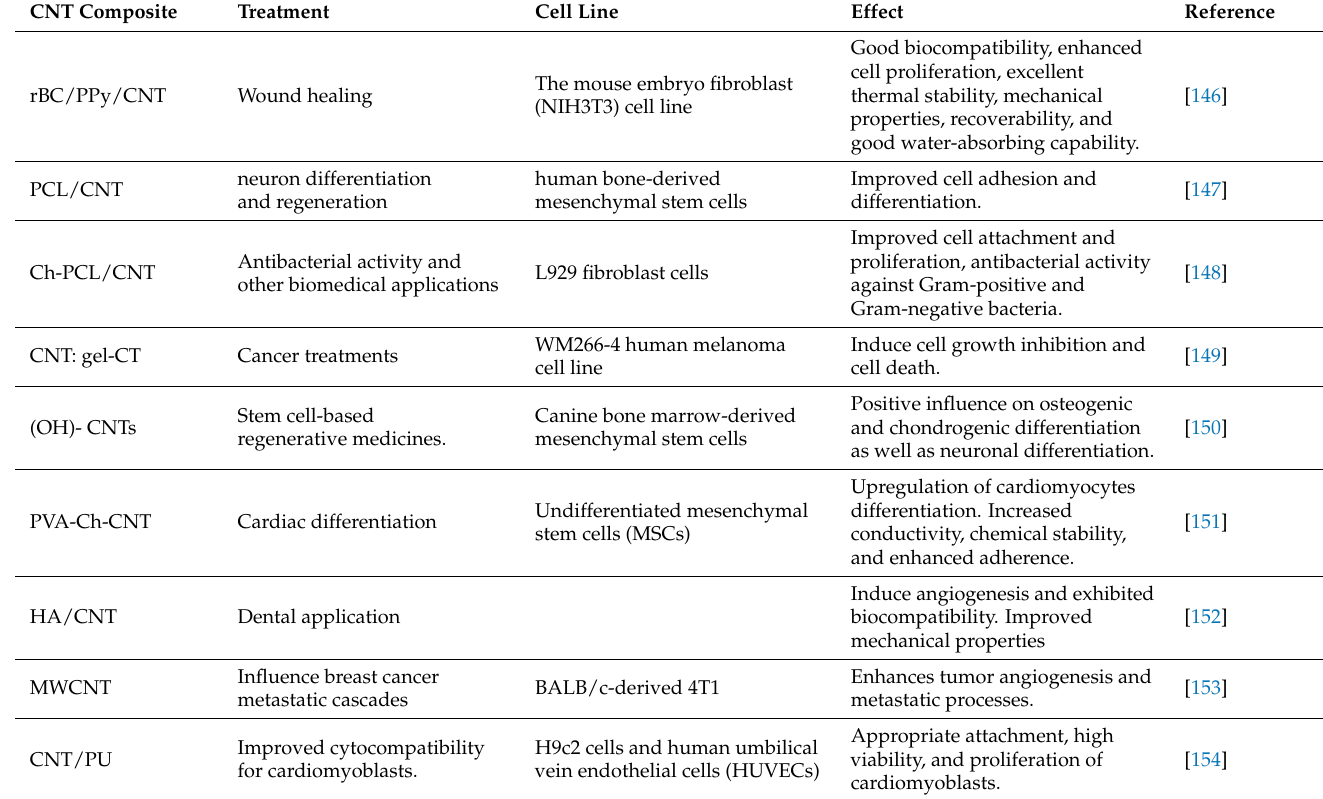
Table 4. Application and aspect of CNT hybrids for cell proliferation and